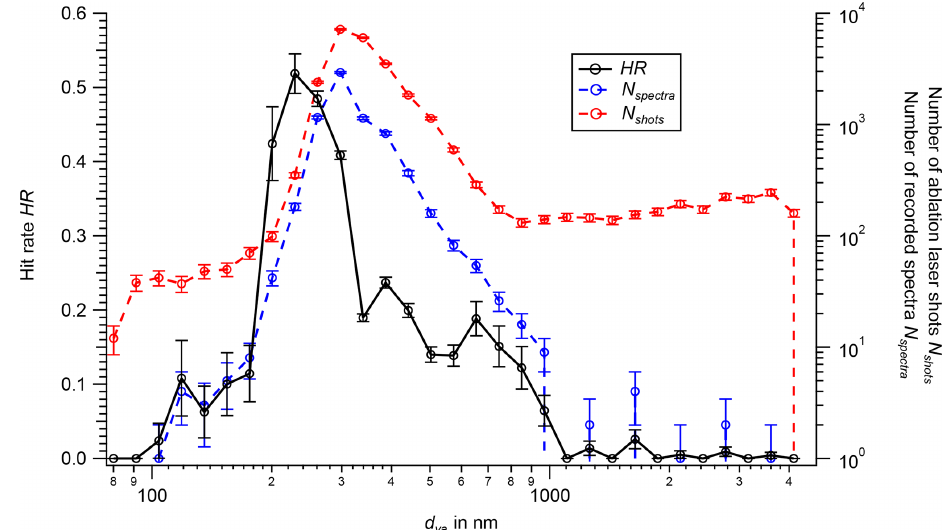
Figure 8. The hit rate HR (black, left ordinate); the number of spectra N spectra (blue, right ordinate, log scale); and the number of detected particles, i.e., ablation laser shots N shots (red, right ordinate, log scale), as a function of particle size d va (logarithmic bin size) for ambient urban aerosol. Only the spectra with size information within the calibrated size range were processed (see Sect. S4 in the Supplement). Uncertainties in HR, N shots , and N spectra are based on counting